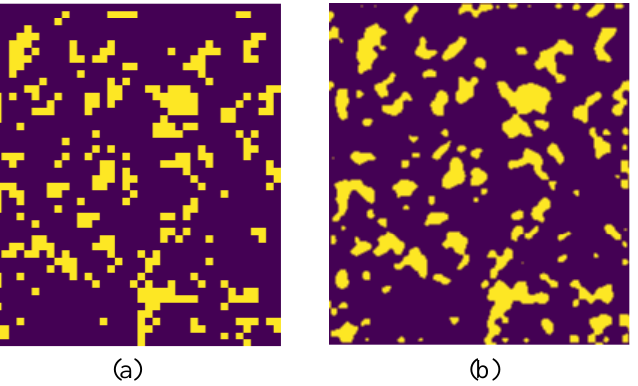
Figure 5. A demonstration of a bitmap using 2D interpolation with the contour parameter c = 0.5. ( a ) original topology (40 × 46), ( b ) interpolated topology (200 × 230). The level of the interpolated topology is determined by a constant c.